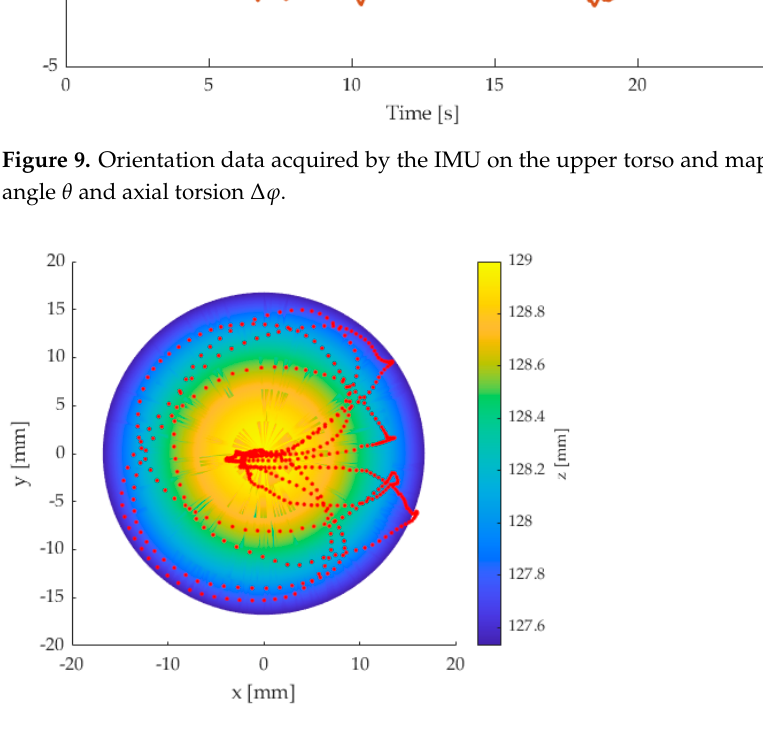
Figure 10. Top view of the acquired teleoperated torso motion and comparison with the computed workspace in Figure 5.